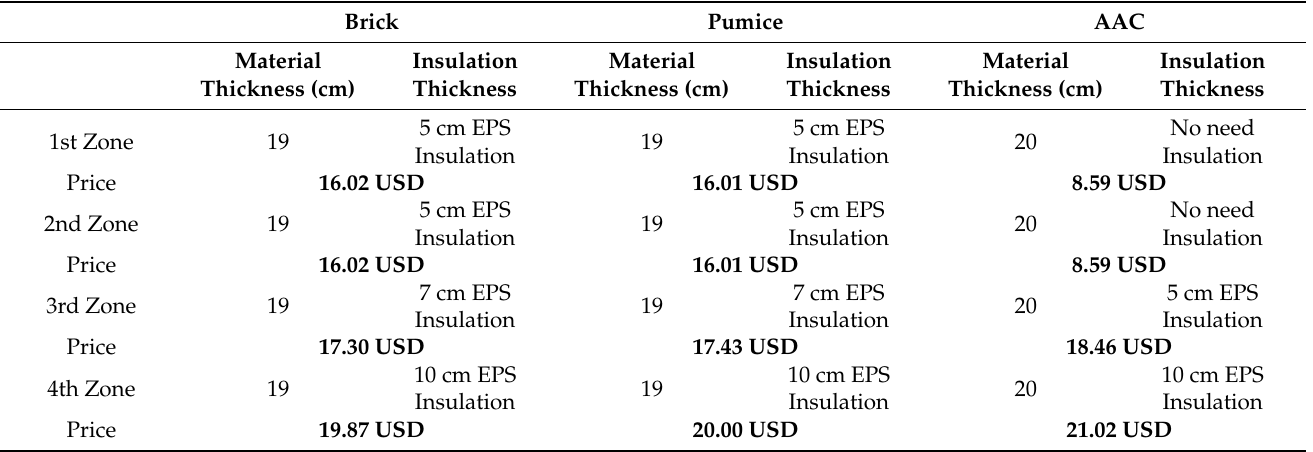
Table 4. Energy saving to wall unit m 2 costs